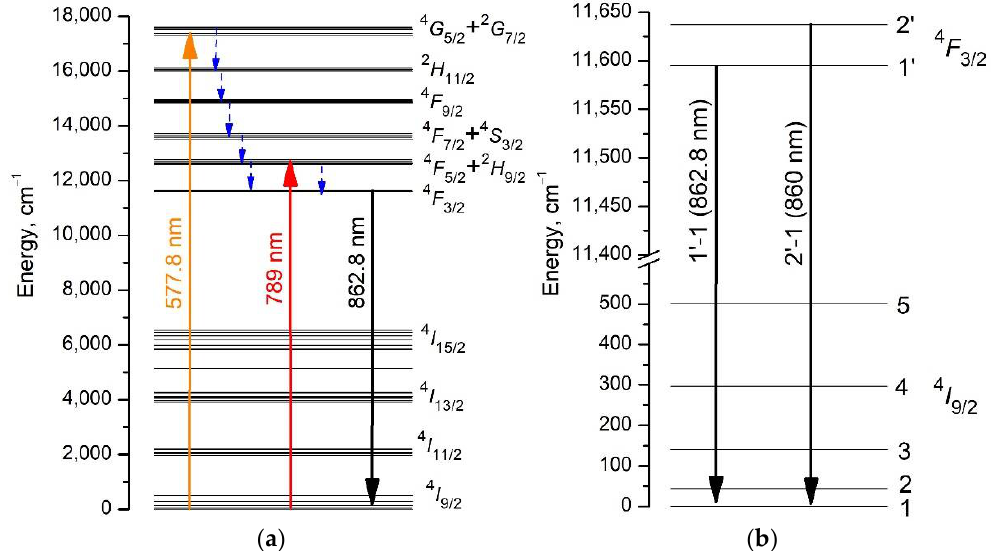
4 F → 4 I 3/2 9/2 (black